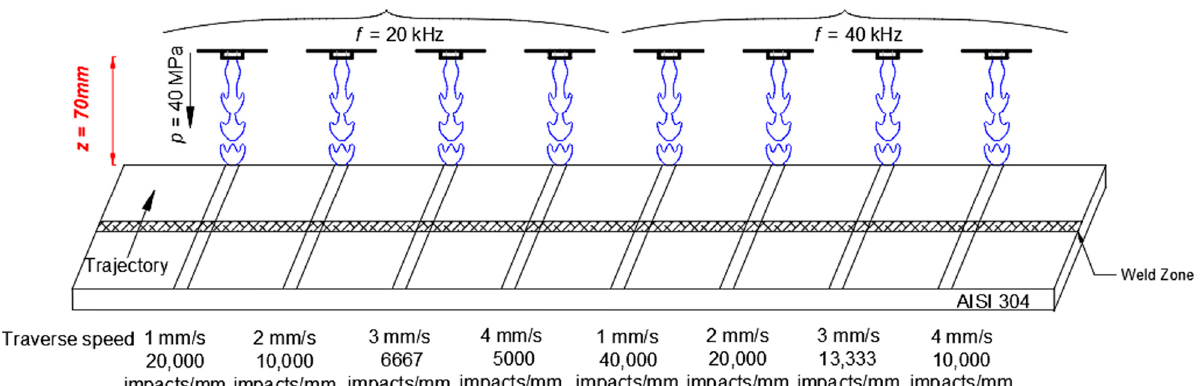
Figure 1. Experimental setup.